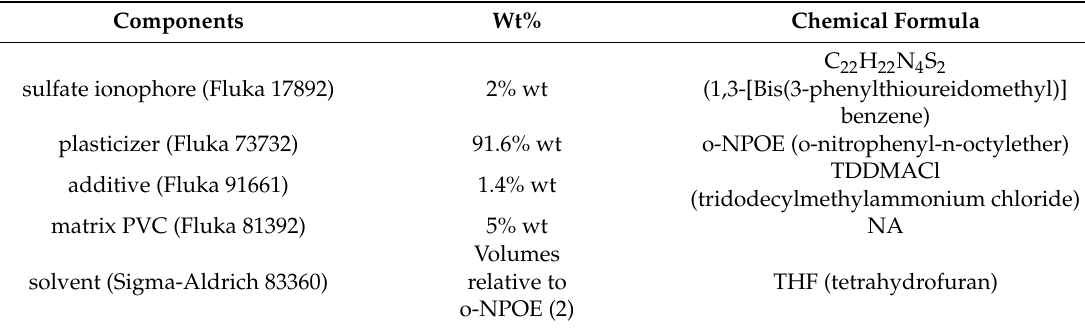
Table 1. Membrane components of the sulfate microelectrodes.